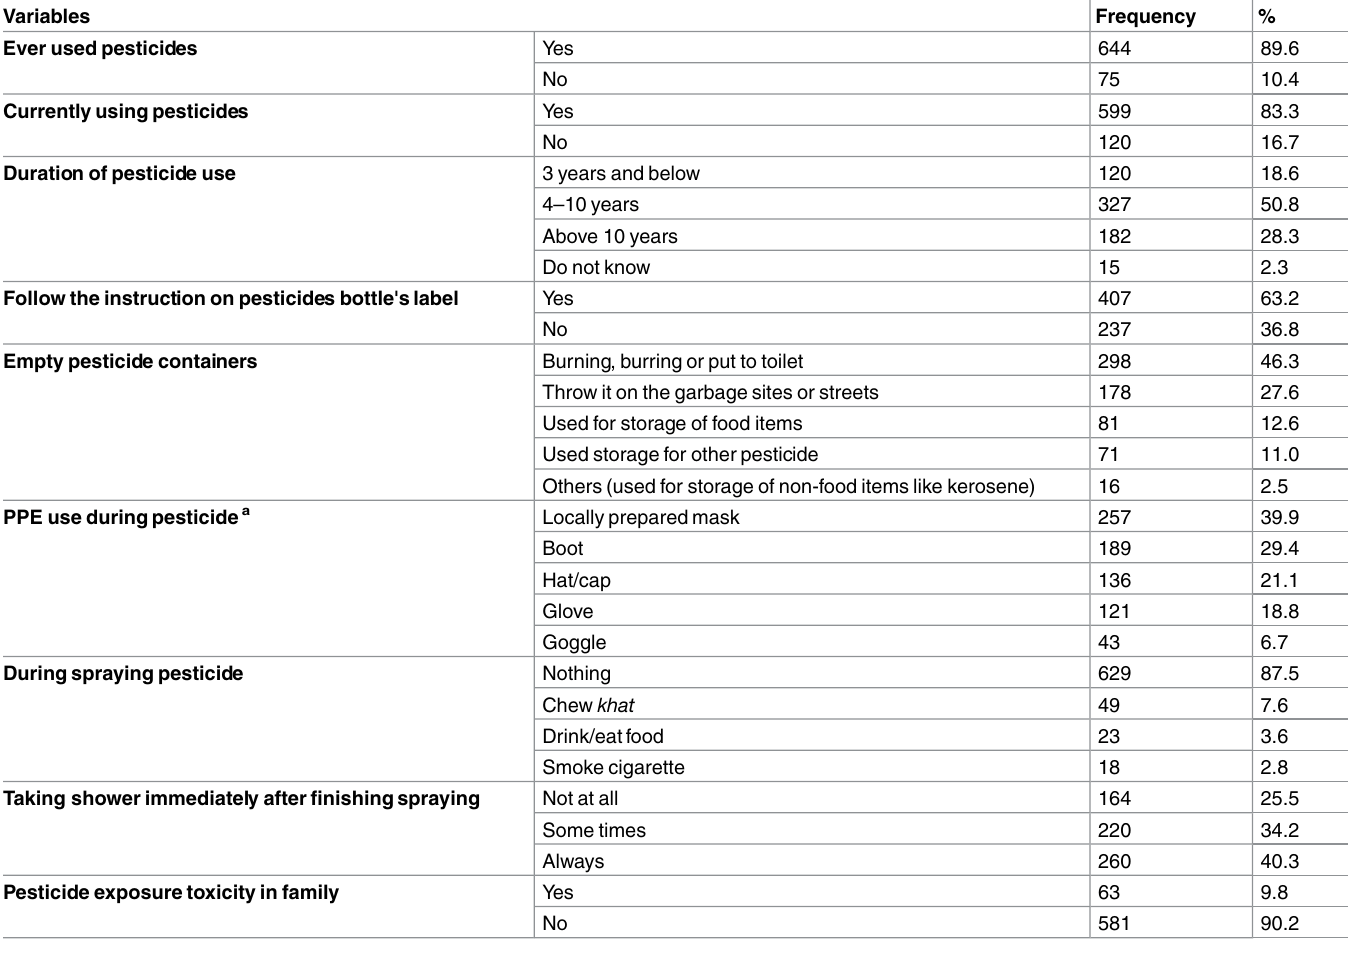
Table 3. Practicefarmers towards safe use of pesticides.